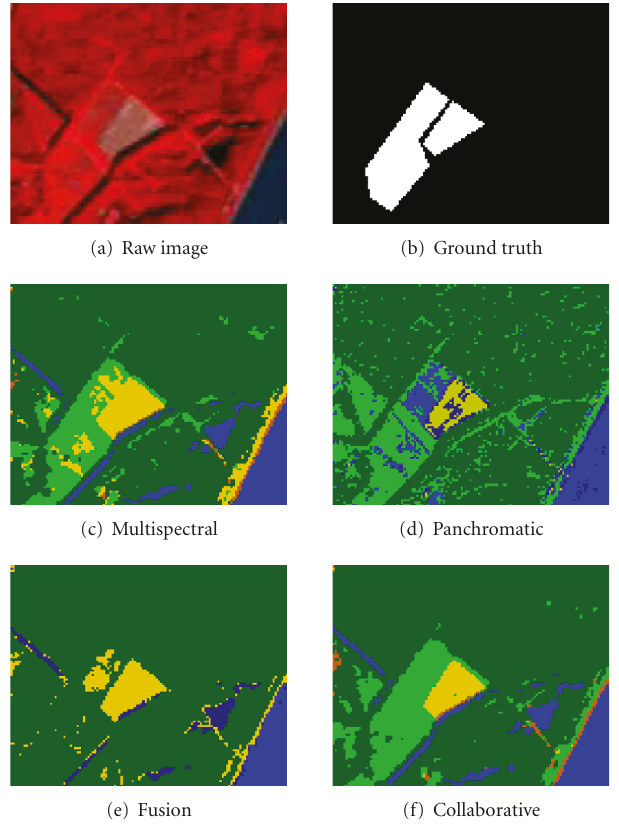
Figure 11: Examples of fields detection. (b) illustrates the ground truth for field (1) (on the left) and field (2) (on the right).